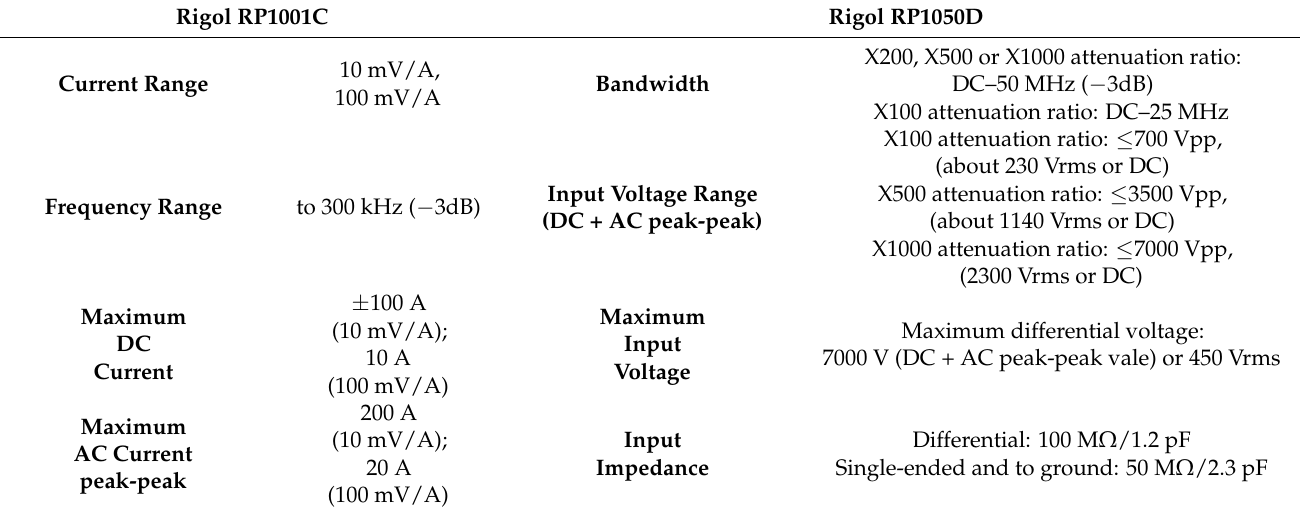
Table 4. The values of selected parameters for the current and voltage probes.